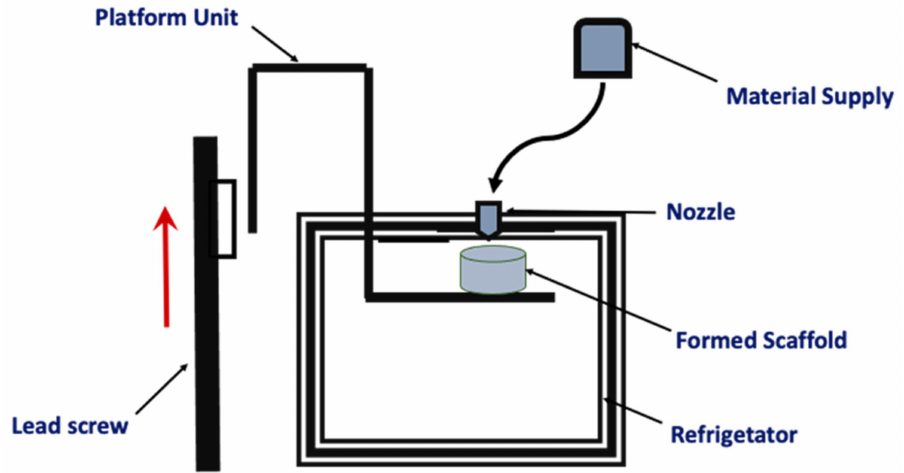
Figure 11. Low-temperature deposition manufacturing